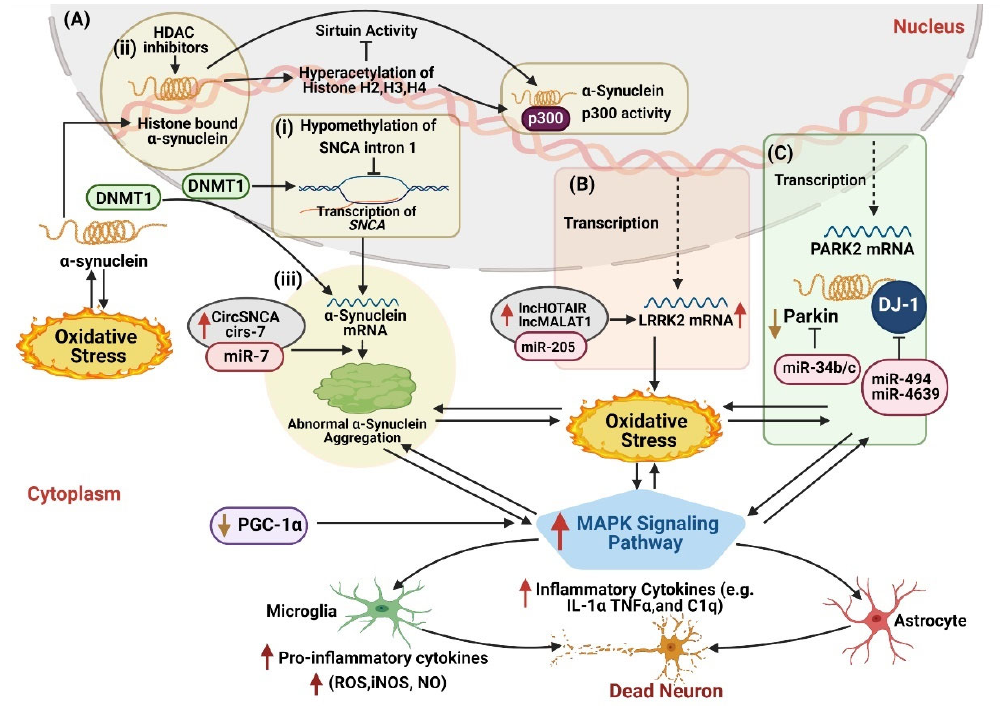
Figure 3. The landscape of synergic epigenetic interactions with MAPK signaling pathway in PD development. ( A ) MAPK signaling pathway is activated due to abnormal accumulation of α‐ synuclein, which activates glial cells and inflammatory cytokines. ( i ) Hypomethylation of the intron 1 of SNCA locus dysregulates SNCA gene transcription, leading to abnormal α‐ synuclein aggregation in the cytoplasm. This allows abnormal α‐ synuclein to enter the nucleus following oxidative stress and sequester DNMT1 into the cytoplasm, enhancing the hypomethylation of SNCA gene and causing dysregulated transcription. ( ii ) Meanwhile, HDAC inhibitors cause hyperacetylation of α‐ synuclein linked histones H2, H3, H4, and p300 promoter region of SNCA to induce α‐ synuclein aggregation. ( iii ) Synergic interaction of DNMT1, circSNCA, and cirs ‐ 7a suppresses miR ‐ 7 expression, which upregulated SNCA gene expression to trigger α‐ synuclein accumulation. ( B ) Similarly, LncHOTAIR1 and lncMALAT1 interact with miR ‐ 205 to overexpress LRRK2 and activates MAPK signaling pathway. ( C ) miR ‐ 34b/c interacts with PARK2 and DJ ‐ 1 to inhibit their neuroprotective role and activates glia cells. miR ‐ 494 and miR ‐ 4639 downregulate DJ ‐ 1 activity and upregulate nitric oxide ten folds to promote neuroinflammation. Moreover, lower expression of PGC ‐ 1 α also contributes to MAPK signaling pathway activation. Altogether, these epigenetic mechanisms interact with each other and with MAPK signaling pathways to induce neuroinflammation in PD development. Note *: ↓ shows downregulated expression, and ↑ shows an upregulated expression.